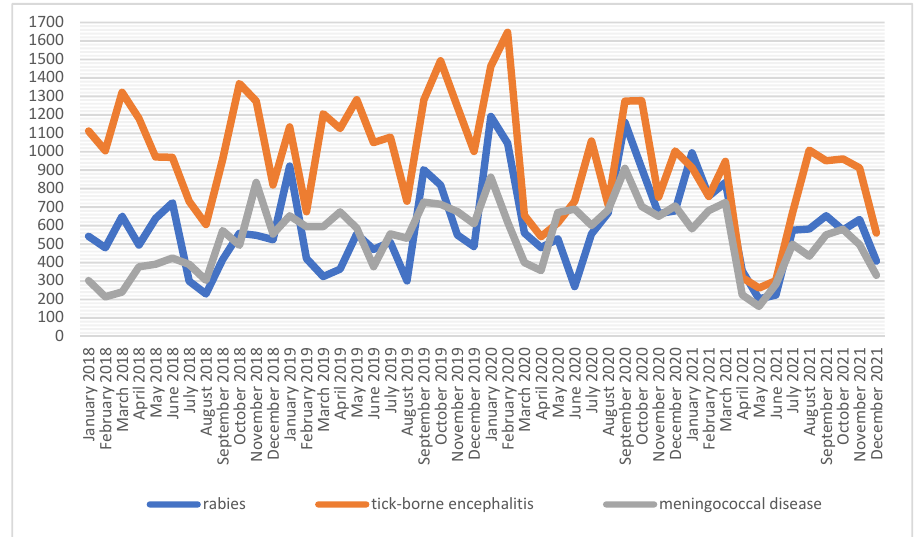
tick-borne encephalitis meningococcal disease Figure 4. Number of vaccinations against rabies, tick-borne encephalitis and meningococcal disease Figure 4. Number of vaccinations against rabies, tick-borne encephalitis and meningococcal disease Figure 4. Number of vaccinations against rabies, tick-borne encephalitis and meningococcal disease among soldiers in 2018–2021. among soldiers in 2018–2021. among soldiers in 2018–2021.